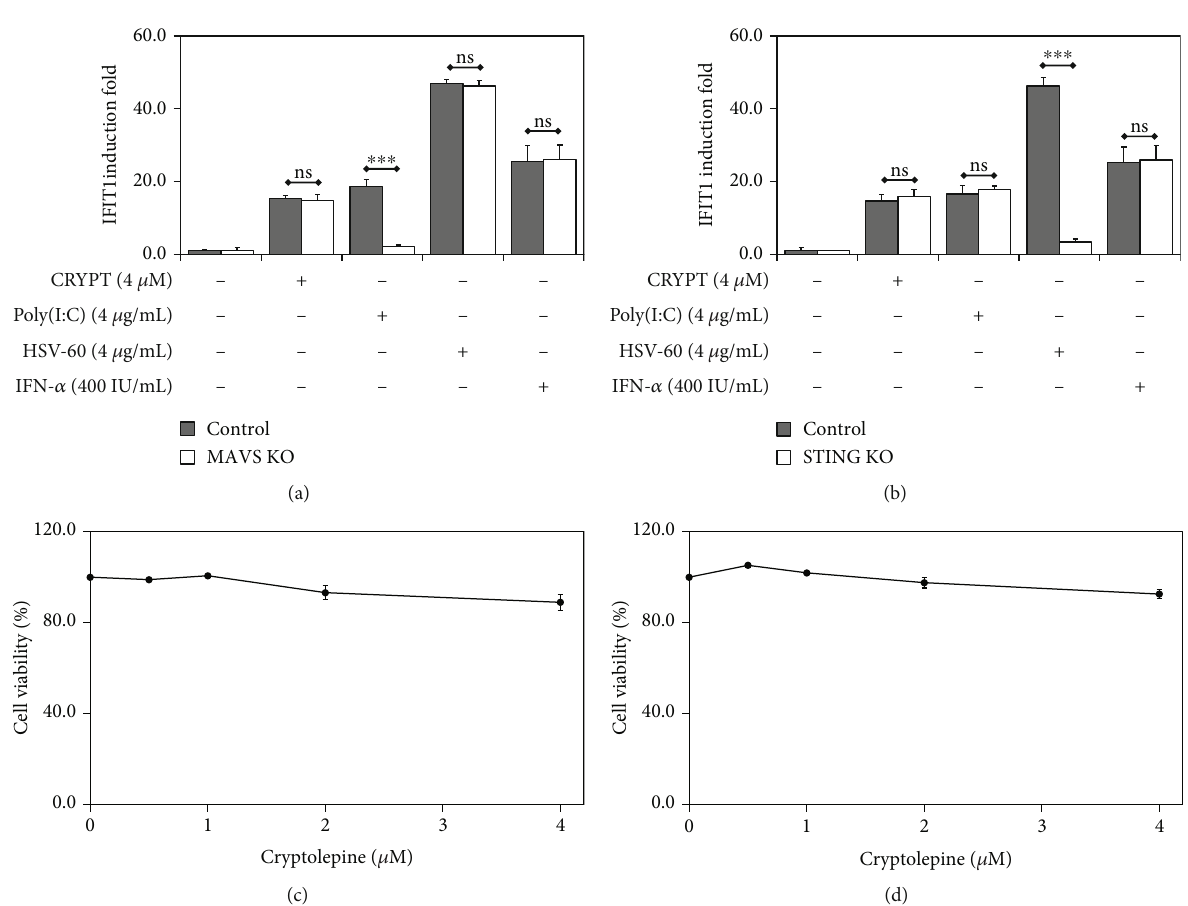
Figure 4: Cryptopine activates IFN-1 response in MAVS and STING-de fi cient THP1-derived macrophages. The derived macrophages from the MAVS (a) and STING (b) de fi cient THP1 cells were cultured with cryptolepine (CRYPT), Poly(I:C), HSV-60, or IFN- α . The derived macrophages from the parent THP1 cells served as the control to which the IFIT1 induction in the de fi cient cells was compared. Also, the cytotoxic e ff ects of cryptolepine on the MAVS (c) and STING (d) de fi cient cells were assessed. Data are shown as the means, from three varied experiments with each done in triplicate, and error bars represent the standard deviations. ∗∗∗ p < 0 : 001 ; ns: di ff erence not signi fi cant (Student ’ s t